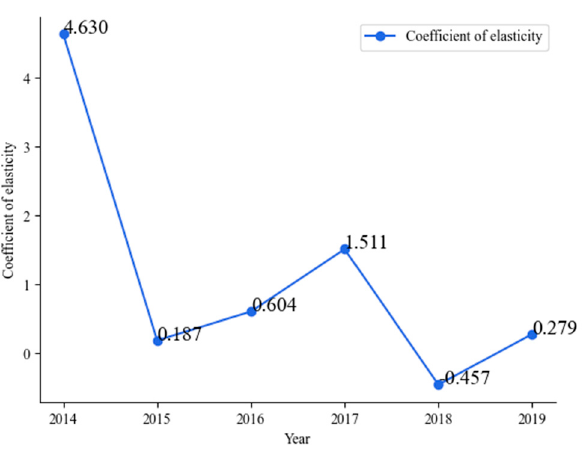
Figure 2. Change trend of the elasticity coefficient of attention of “AI + education” in Guizhou province from 2014 to 2019.